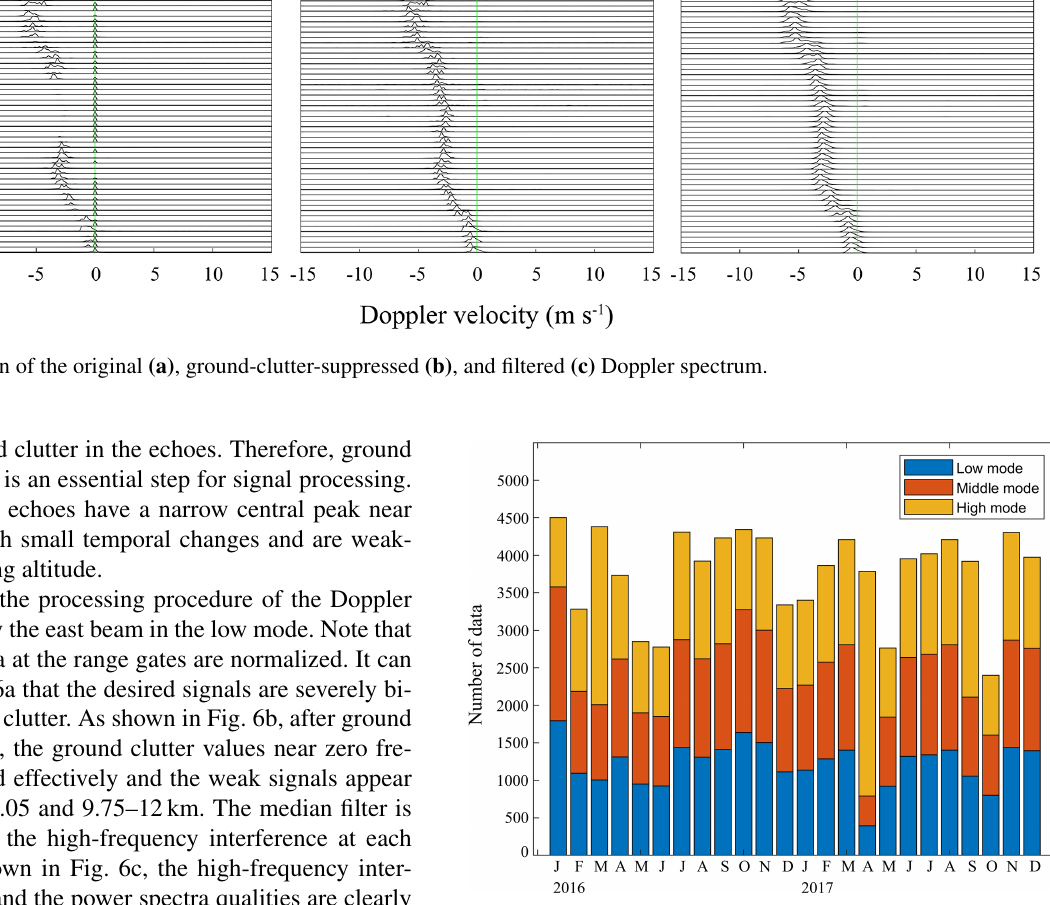
Figure 7. The monthly total number of the Wuhan MST radar data in three observation modes during January 2016 to December 2017. Blue for low mode, red for middle mode, and orange for high